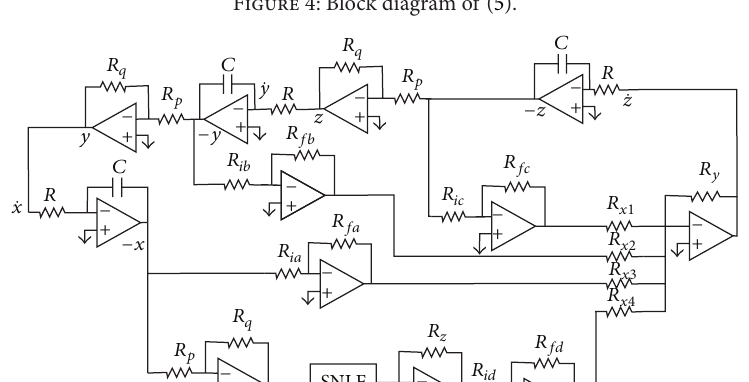
Figure 4: Block diagram of (5).